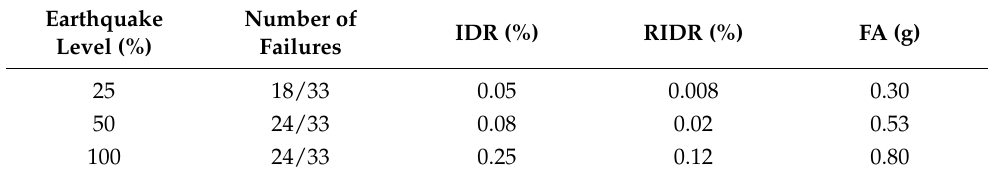
Table 5. Number of failures and peak IDR, RDIR, FA values-case (ii): flexural hinges.